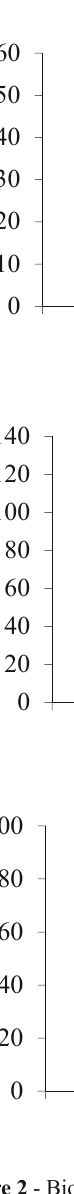
Figure 2 - Biological characteristics of the adult of Dichelops melacanthus developted on Bt and non- Bt soybean pods. Means were compared by Tukey test.